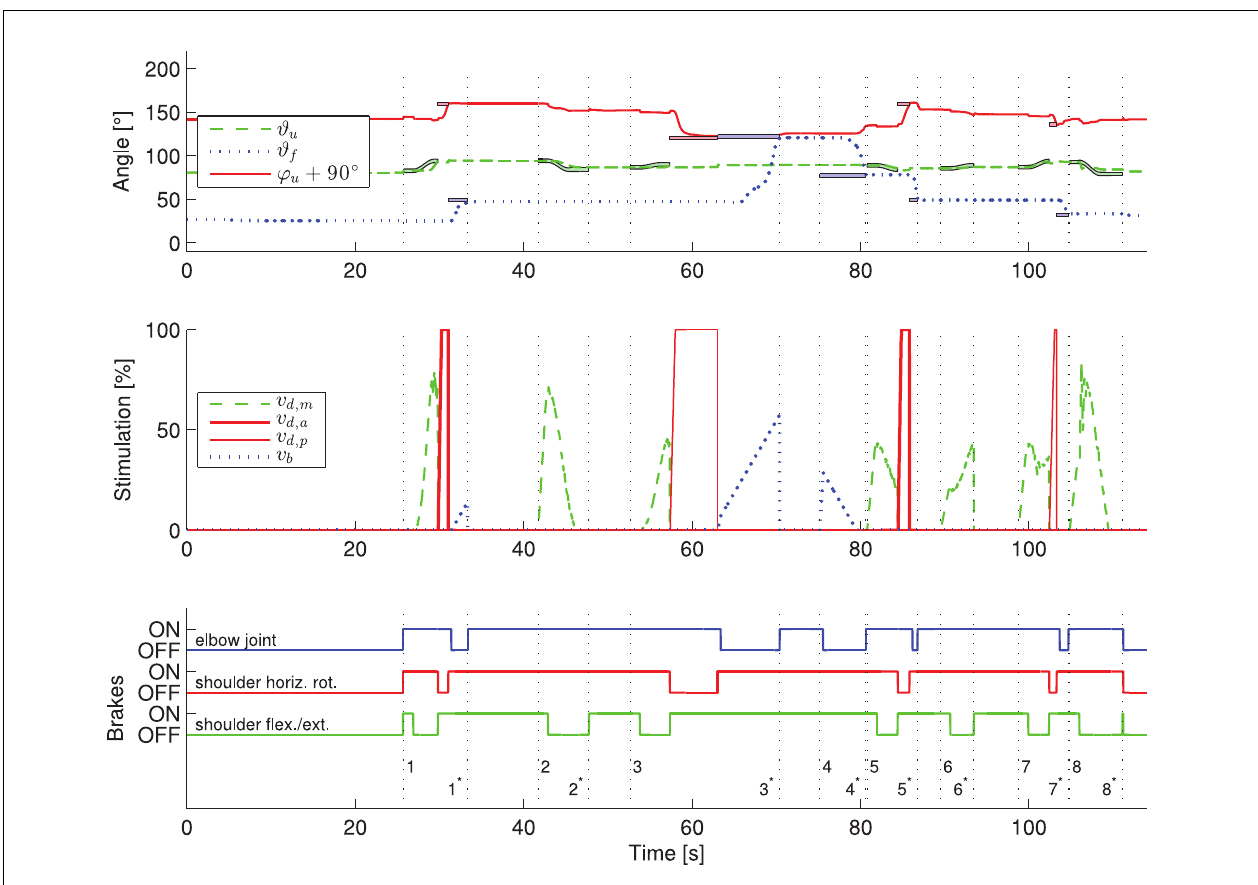
FIGURE 9 | Exemplary results of the application of the developed control system to one healthy subject. The transient behavior for one trial of the described drinking task is shown. The numbers on the vertical dashed lines in the third subplot indicate the begin (without star) and end (with star) of the eight arm movements defined in Figure 5 . In the first subplot, the active reference angles (bold colored lines with black surrounding) are shown along with the measured angles. In the figure, the colors blue, green and red